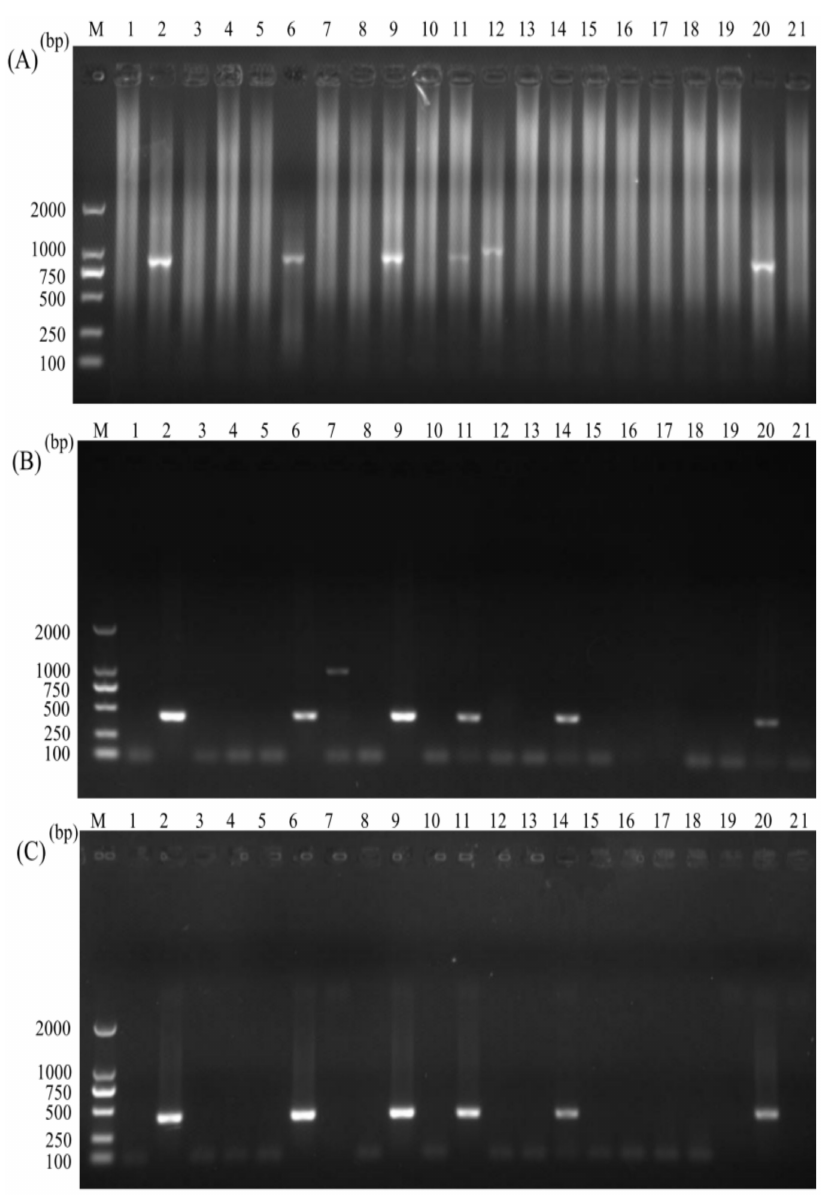
Figure 5. Detection of C. parvum in clinical samples by using the nested PCR ( A ), the normal PCR ( B ) and the nano-PCR assays ( C ). Lane M: DL2000 DNA Marker (TaKaRa); lanes 1–20: faecal samples of calves; lane 21: negative